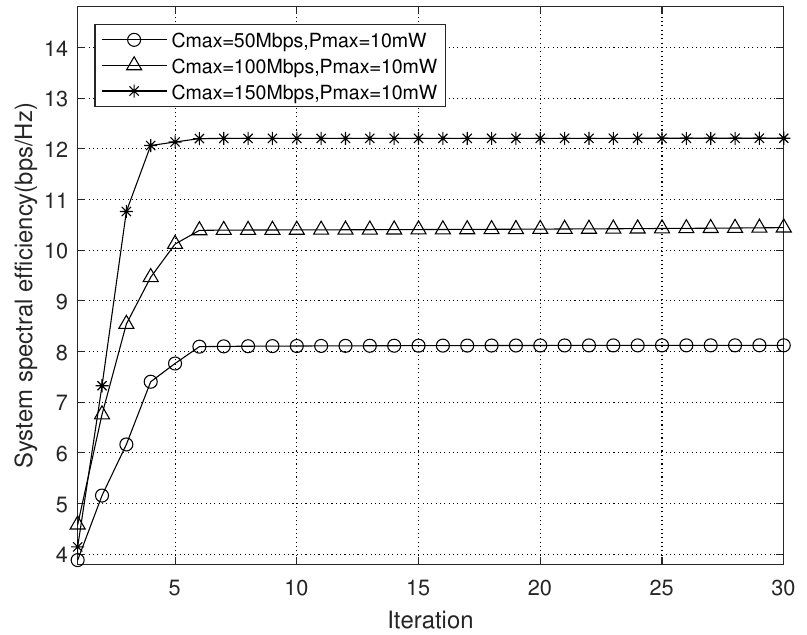
Figure 2. Convergence of the joint optimization algorithm for user scheduling and resource